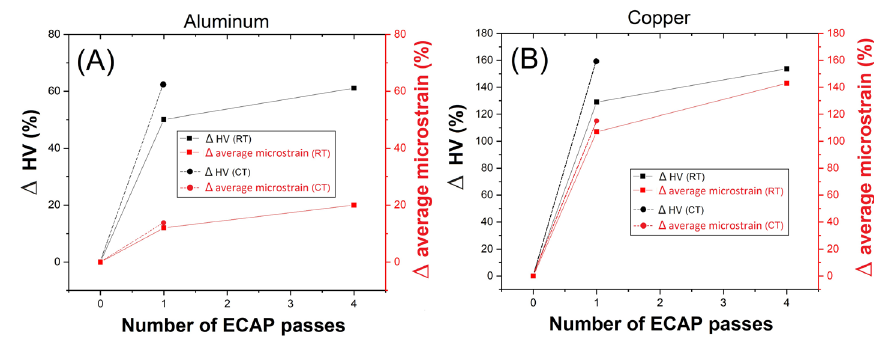
Figure 10. Variation of hardness and microstrain for aluminum (A) and copper (B) on different